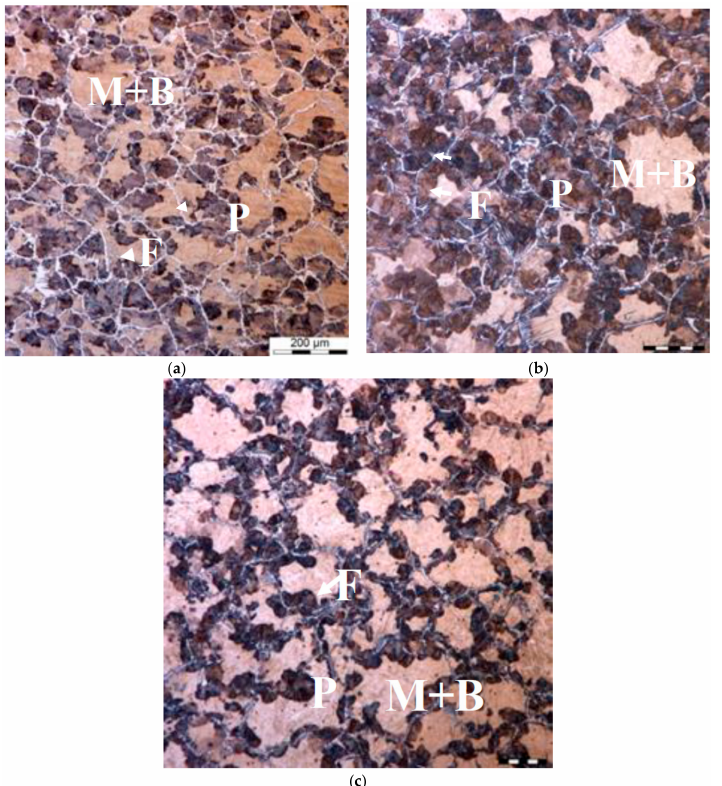
Figure 12. Point Q variant 2—microstructures of the samples after first cooling to 609 ◦ C ( a ), after heating to the holding temperature ( b ) and at the end of holding ( c ).